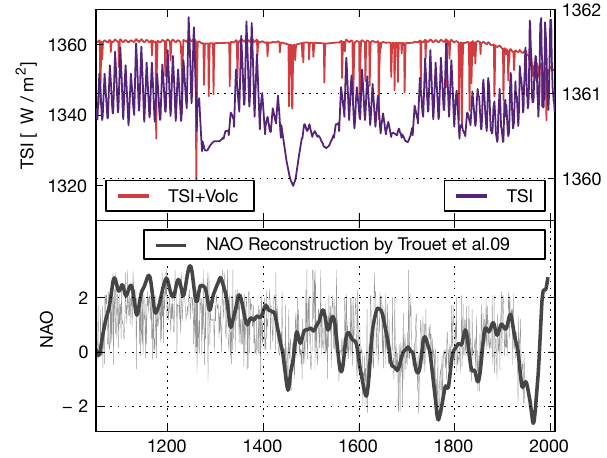
Fig. 1. Externally prescribed forcing time series as applied in our simulations. Upper panel: the TSI forcing time series by Steinhilber et al. (2009) (purple) and the full top-of-the-atmosphere short-wave TSI forcing including aerosols from volcanic eruptions and anthropogenic emission (red). Lower panel: based on NAO reconstructions by Trouet et al. (2009) and NCEP/NCAR reanalysis data, wind-stress patterns were stochastically constructed as described in Sect. 2. Out of ten ensemble members, one NAO time series is shown in light grey for comparison.